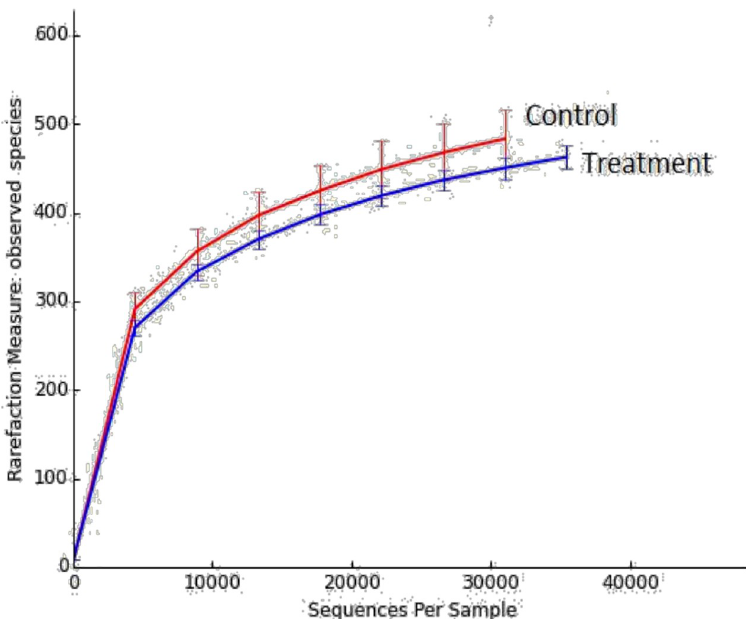
Fig 3. Rarefaction curves of observed species in groups. Control = without multi-enzyme; Treatment = with multi- enzyme.